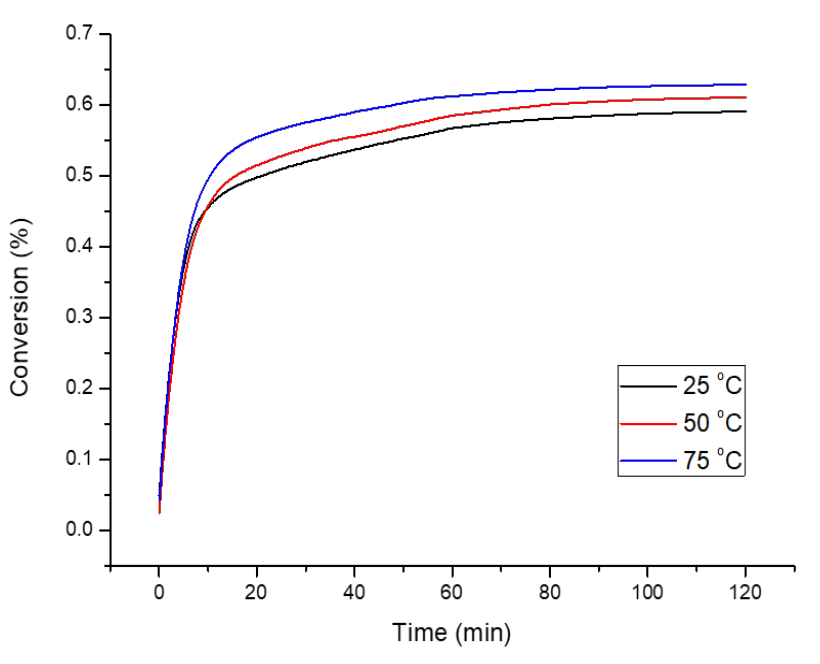
Figure 15. Gas consumption curves of OSA compacts cured at 25 °C, 50 °C, and 75 °C.